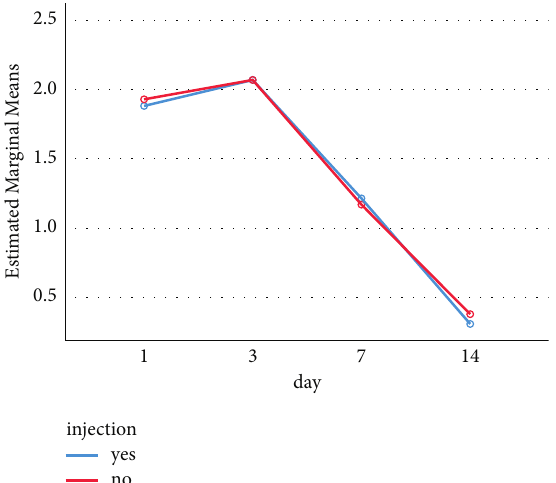
Figure 3: The reduction of ecchymosis on days 1, 3, 7, and 14 based on having or not having an injection. According to the reduction chart, the rate of reduction after 14 days in both groups was statistically significant ( p < 0 . 001). But no significant difference was observed between the groups ( P � 0 .